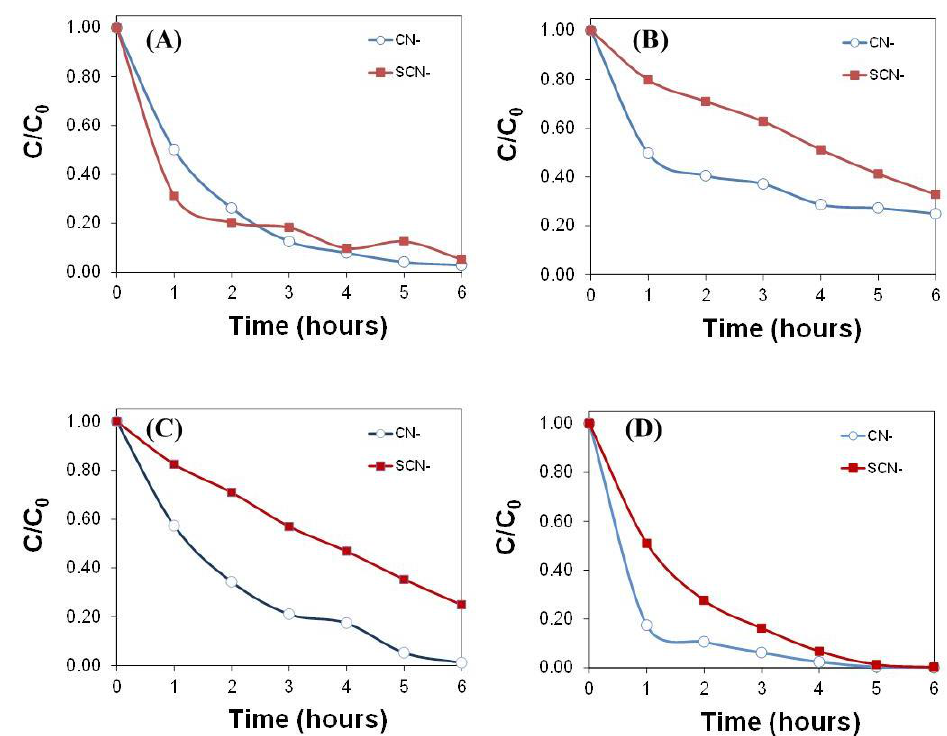
Figure 1. Evolution of the concentration of cyanides and thiocyanates in the wastewater upon illumination with various light sources: ( A ) UVC lamp; ( B ) UV-Vis lamp; ( C ) SimSolar lamp; ( D ) SimSolar lamp in the presence of TiO 2 as photocatalyst.